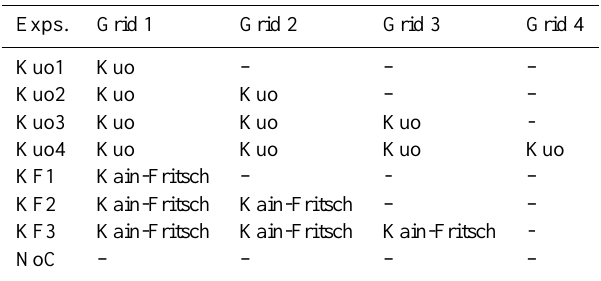
Table 3. RAMS convective parameterization settings